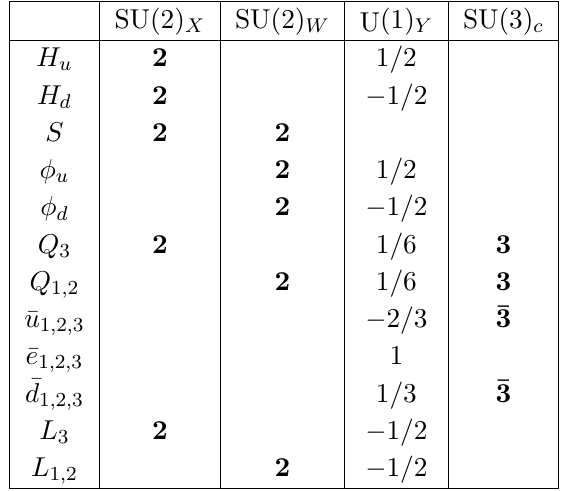
Table 1 . The matter content of the